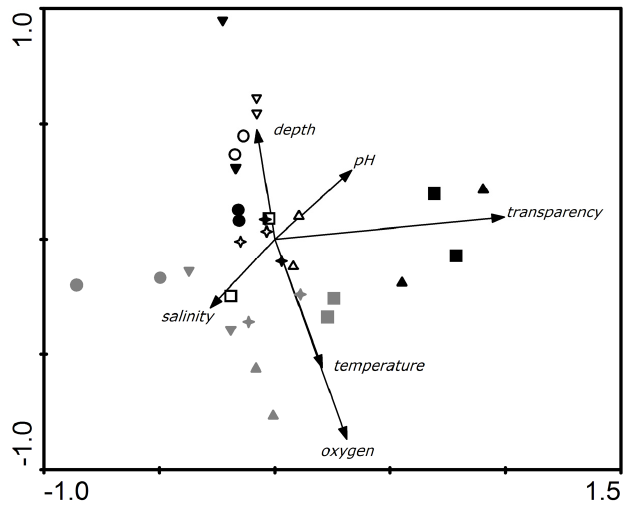
Figure 2. PCA carried out with the abiotic data, where axis 1 is horizontal and axis 2, vertical. Label: white symbols: pre-dredging (2016); gray symbols: during dredging (2017); black symbols: post-dredging (2018). ▲ , Urca Beach; ■ , Flamengo Beach; ● , Engenho; +, Seaport; ▼ , Paquetá.